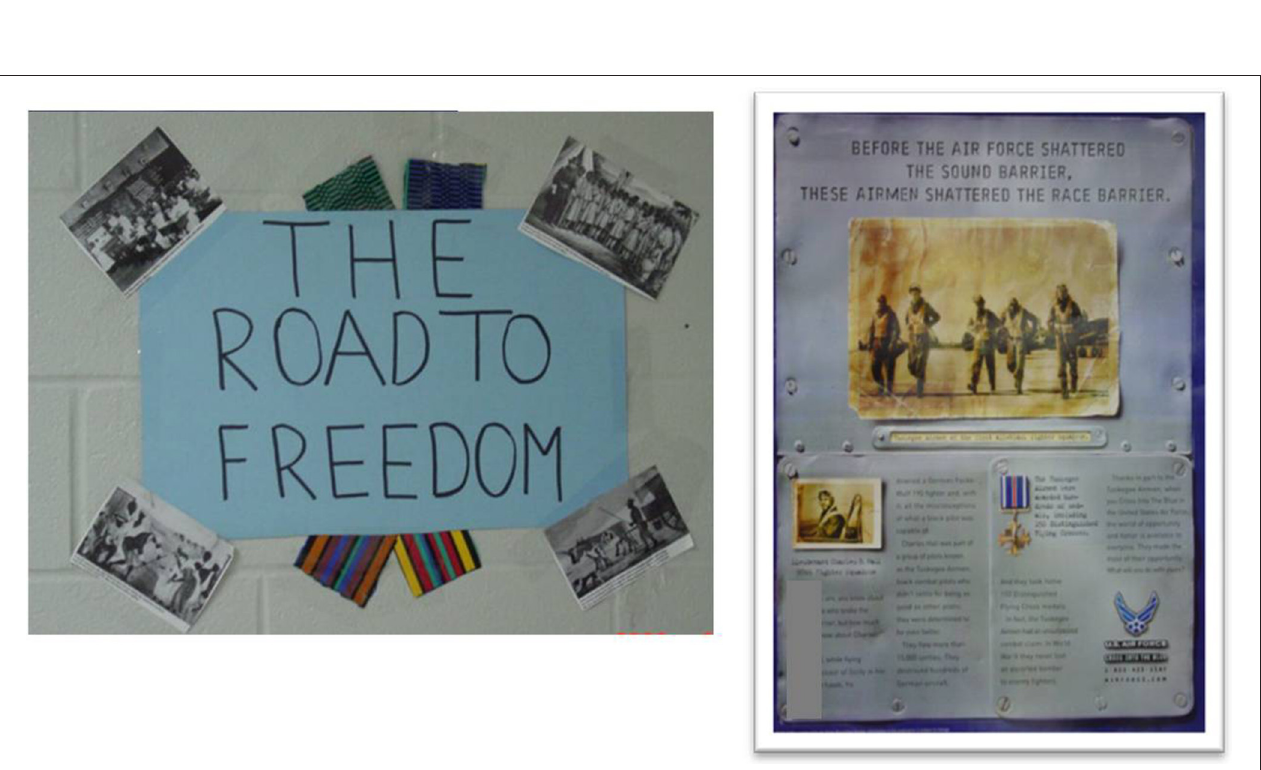
FIGURE 4 | Examples of materials from a Black-Majority school that linked Black History Month to historical racism, Study 1.